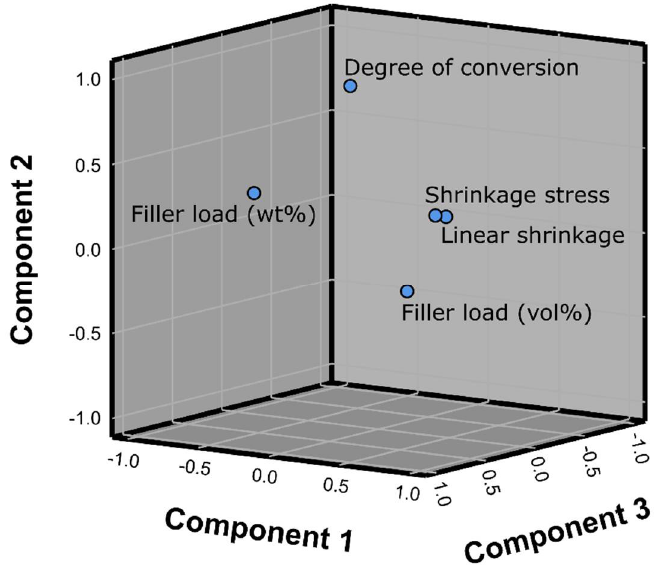
Figure 4. The component loading plot in rotated space for representing the amount of covariance among degree of conversion, linear shrinkage after 5 min, shrinkage stress after 5 min, and filler load expressed in wt% and vol%.